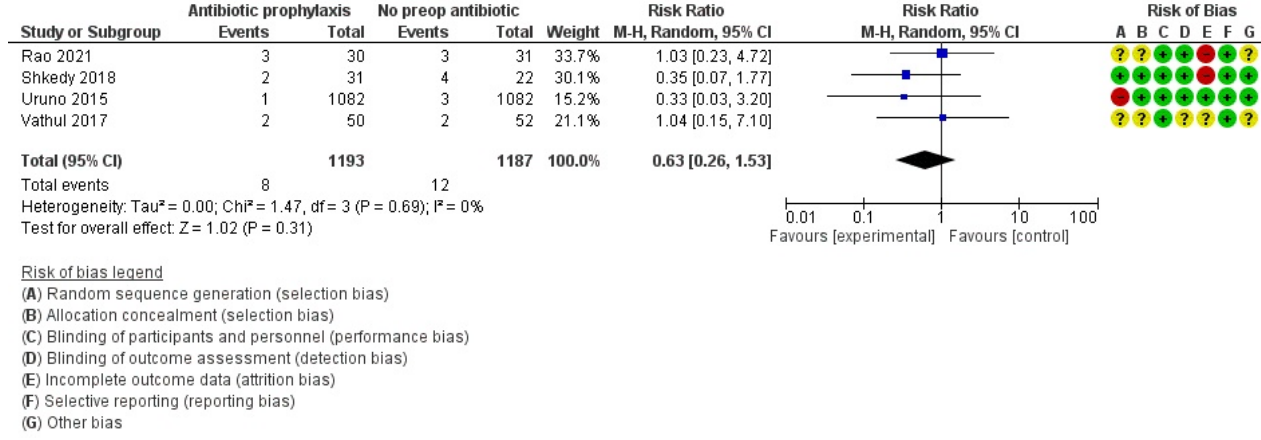
Figure 3. Forest plot for SSI rate in AP group vs. control group (no AP)—All studies.